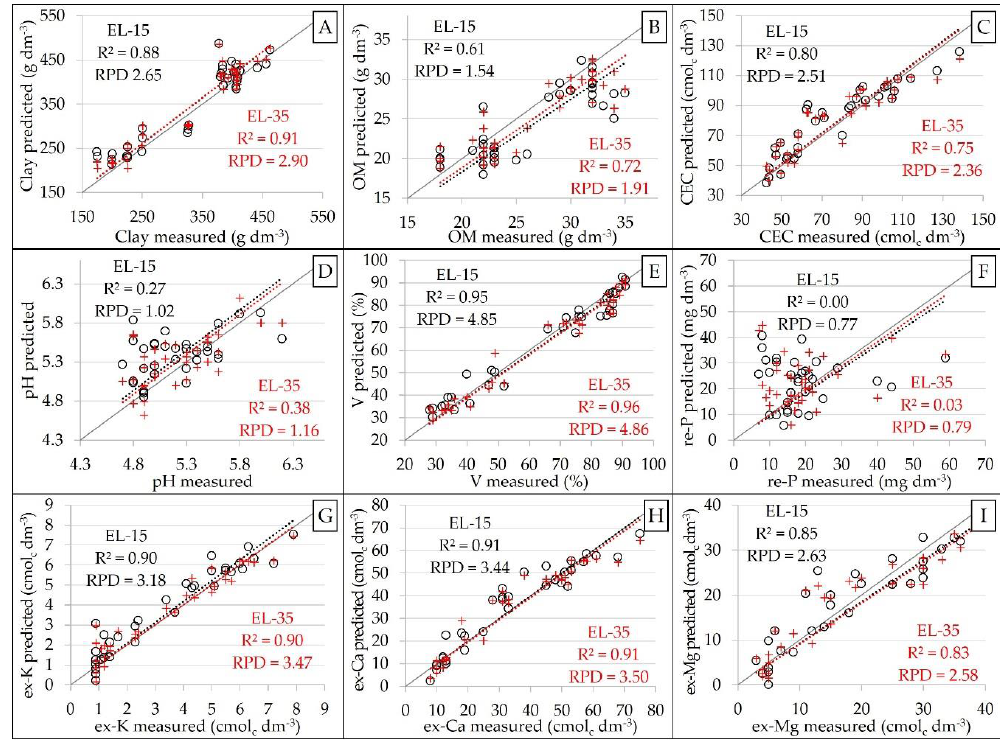
Figure A2. Scatter plots (for the calibration set, n = 34) of measured versus predicted clay, organic matter (OM), cation exchange capacity (CEC), pH, base saturation (V), resin-extracted (re-) P, and exchangeable (ex-) K, Ca, and Mg ( A – I , respectively), which are predicted using multiple linear regressions (MLR). The data of EL-15 and EL-35 scenarios were represented by circles and crosses, respectively. The coefficient of determination (R 2 ) and residual prediction deviation (RPD) values are presented in black and red for EL-15 and EL-35 scenarios, respectively.